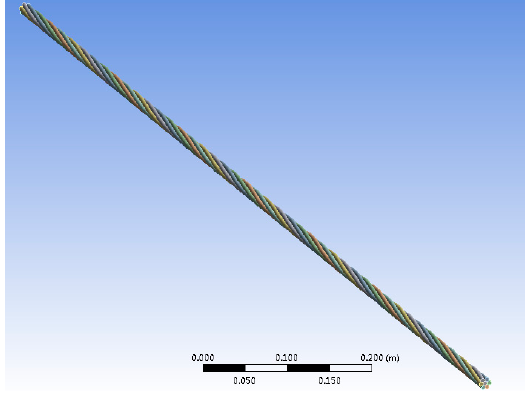
Figure 14. Finite element model of a seven-wire strand. Appl. Sci. 2020 , 10 , x FOR PEER REVIEW